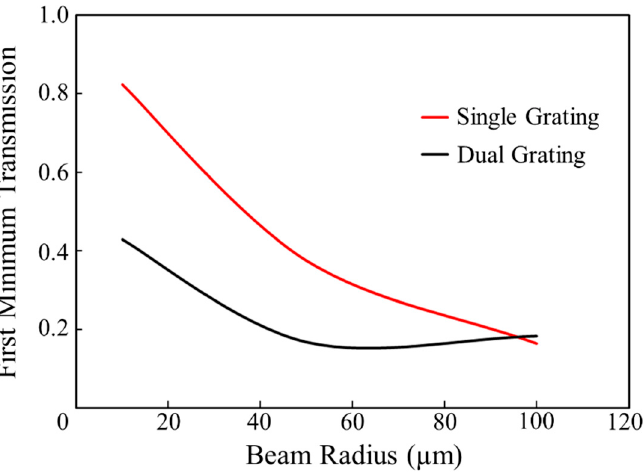
Figure 3. The first minimum transmission versus incident beam radius for the single-grating and the dual-grating EOPBD for θ L < 1. The first minimum transmission is higher for a smaller beam radius, showing a poorer deflection efficiency. The dual-grating configuration gives a better deflection efficiency for a smaller beam radius, compared to the single-grating one.